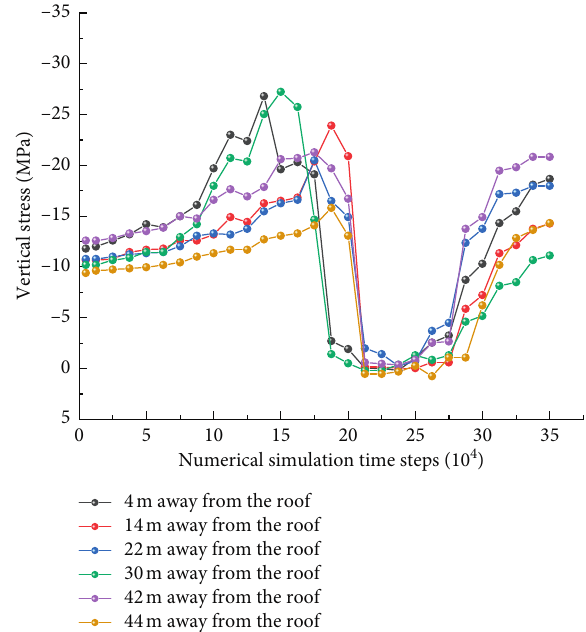
“Asymmetric-oblique-quadrilateral” fracture development body LineRupture Rupture Line Figure 14: Monitoring results of changes of vertical displacement of the roof of the working face.